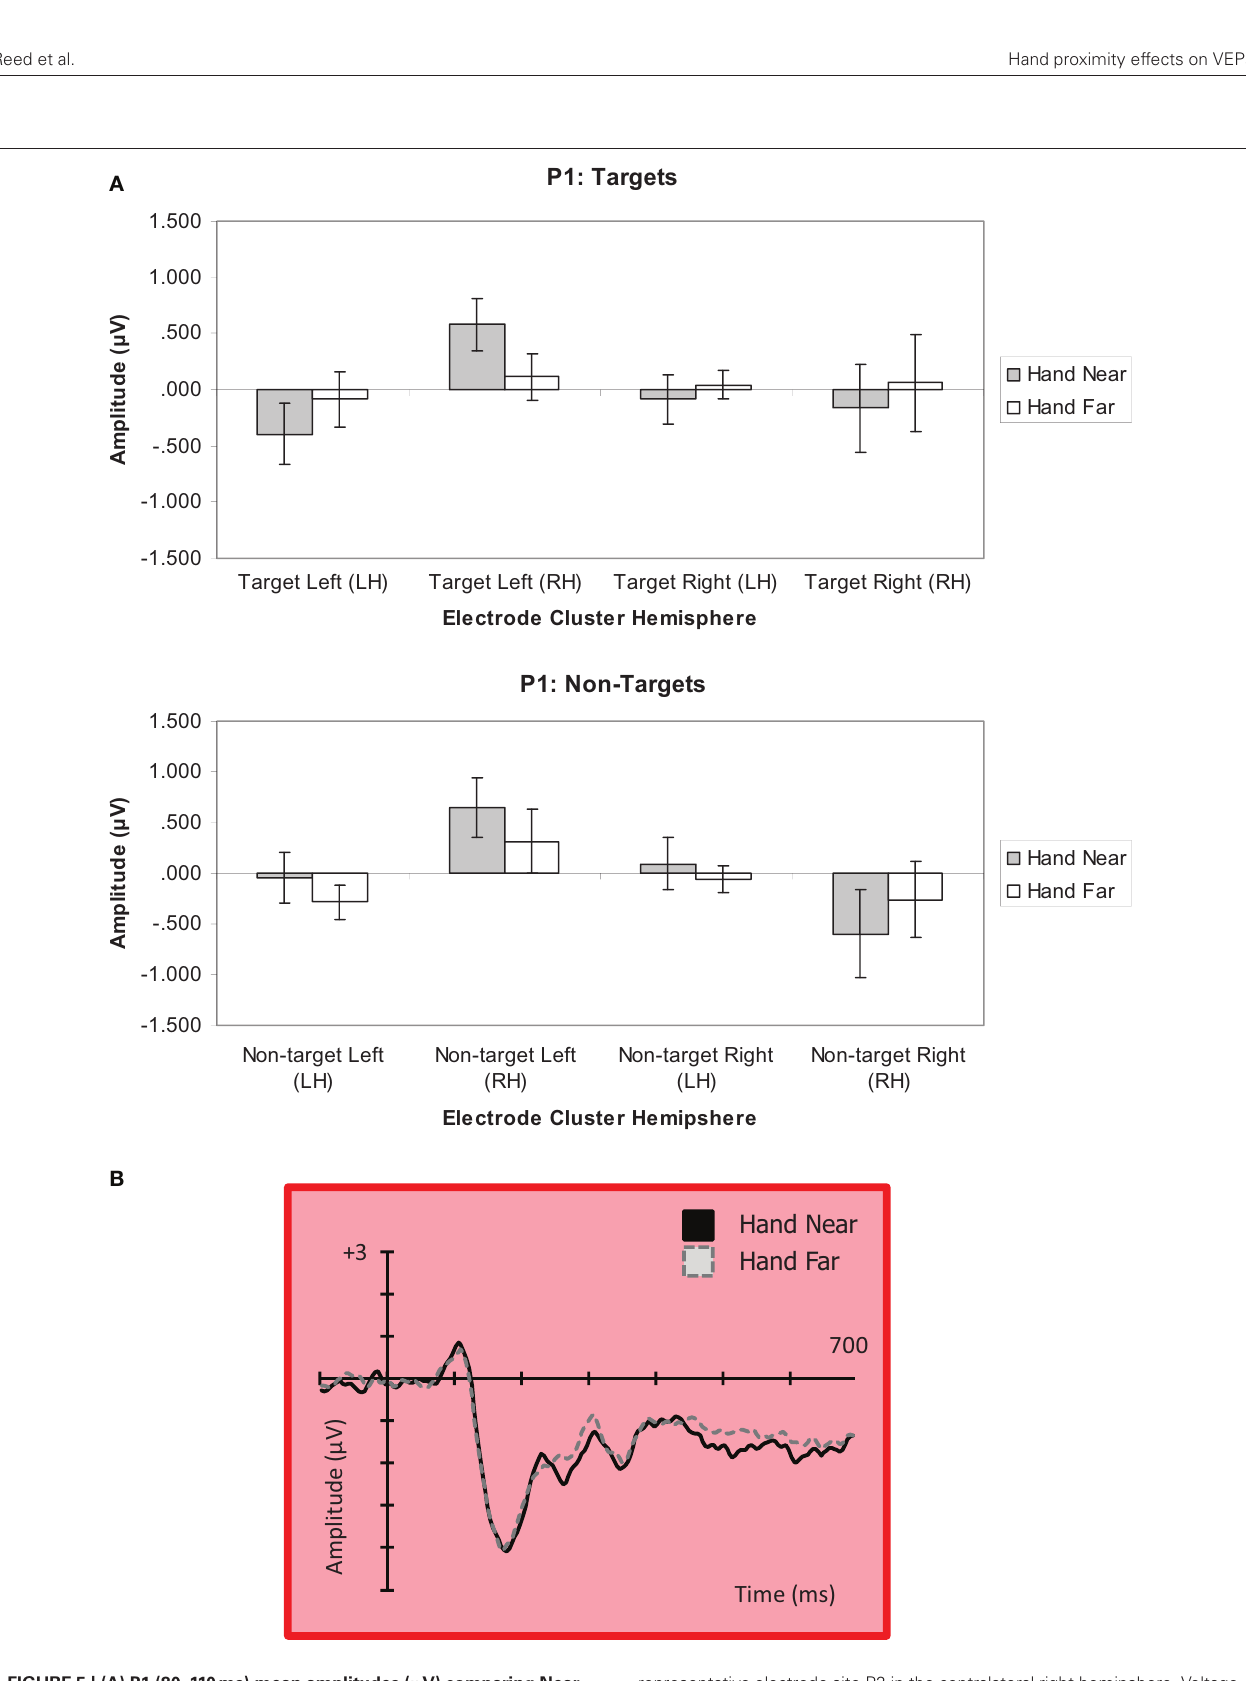
representative electrode site P2 in the contralateral right hemipshere. Voltage is plotted as a function of time, 100ms pre-stimulus onset to 700ms post-stimulus onset. The left Near condition produced a significant effect in the right